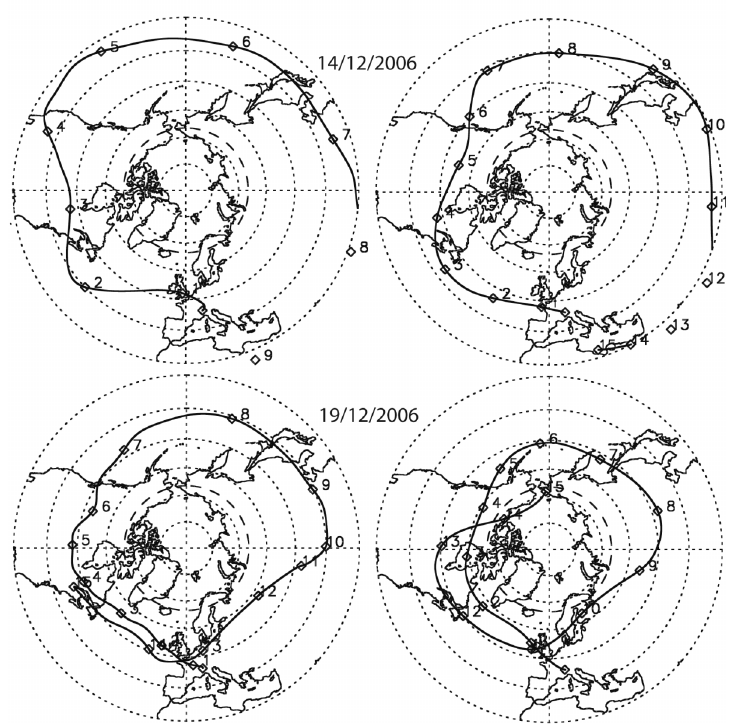
Fig. 3. 15-day back trajectories at 350 K (~13 km altitude; top and bottom left ) and 430 K ( ∼ 18 km altitude; top and bottom right ) ending over Testa Grigia on 14 December ( top ) and 19 December ( bottom ), 2006. For each of the four plots, five trajectories were calculated and only the resulting average trajectory is shown (see text for details). Numbers along each trajectory indicate the distance in days before the arrival of the air parcel at Testa Grigia. Trajectories are not drawn when they pass below 30°N. Back trajectory calculations are from the NASA/Goddard Space Flight Center (NASA/GSFC) «automailer» system initiated with NCEP reanalysis mete- orological data (Schoeberl and Sparling,